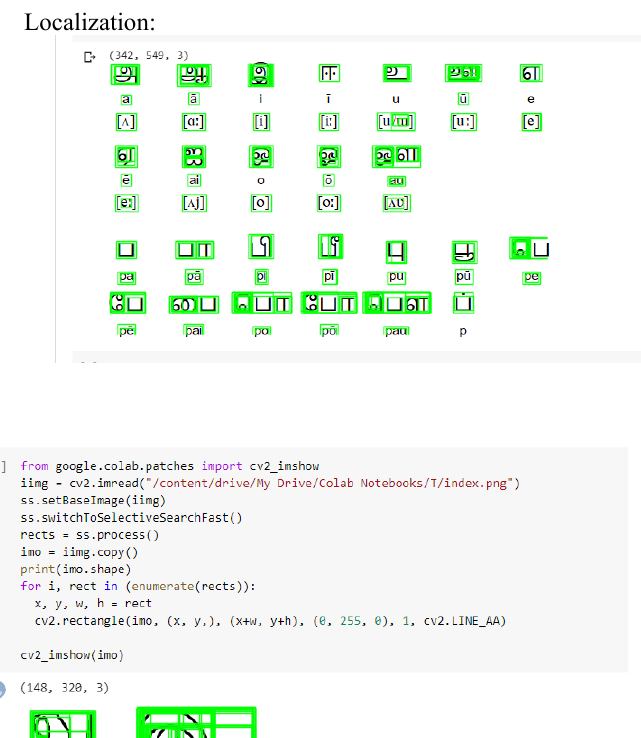
Graph 5. Model accuracy